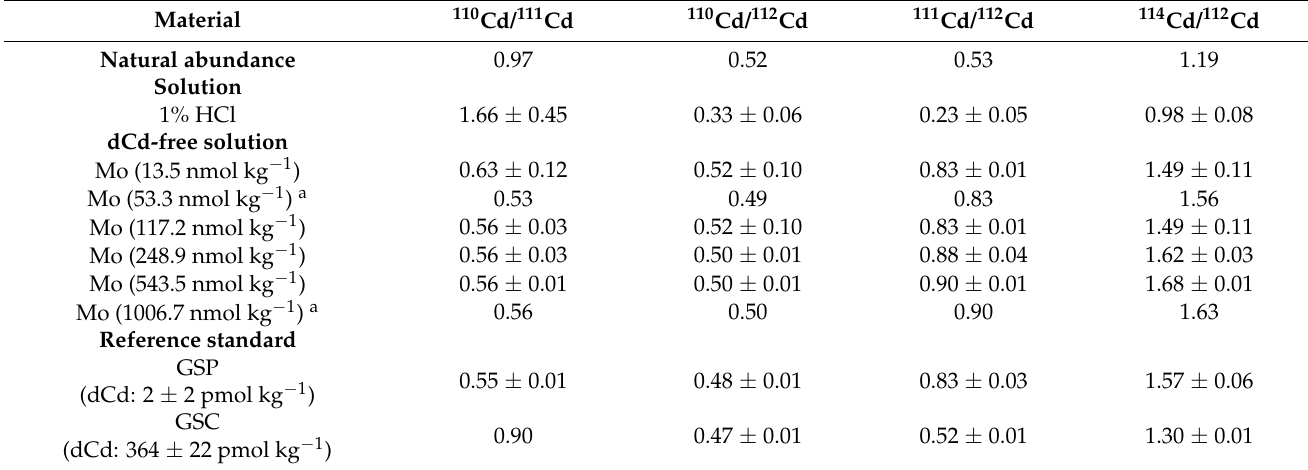
Table 8. Ratios of instrumental signals based on multiple Cd